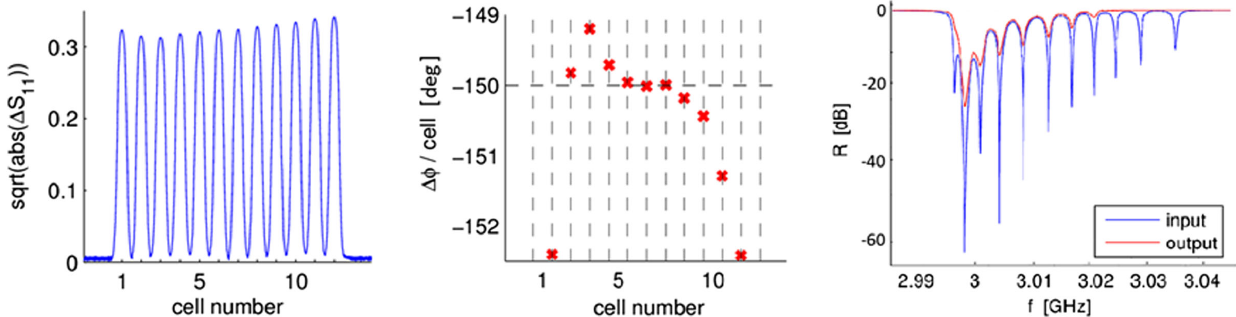
FIG. 6. Measured electric field pattern in magnitude (left) and phase (middle) and the input and output S11 values (right) of the tuned structure in a dry nitrogen atmosphere at 23